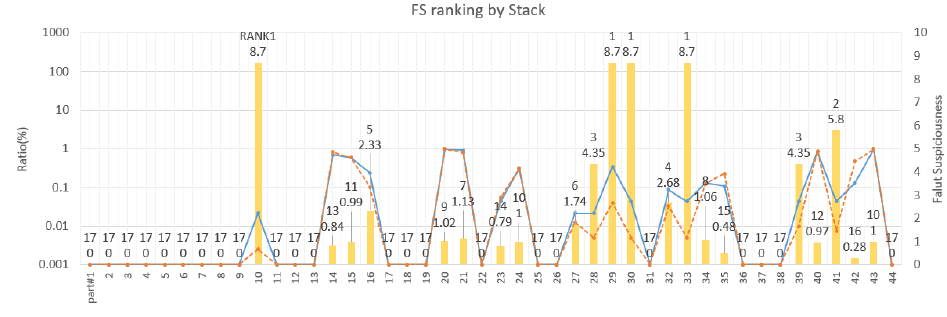
Figure 14. FS ranking by stack.